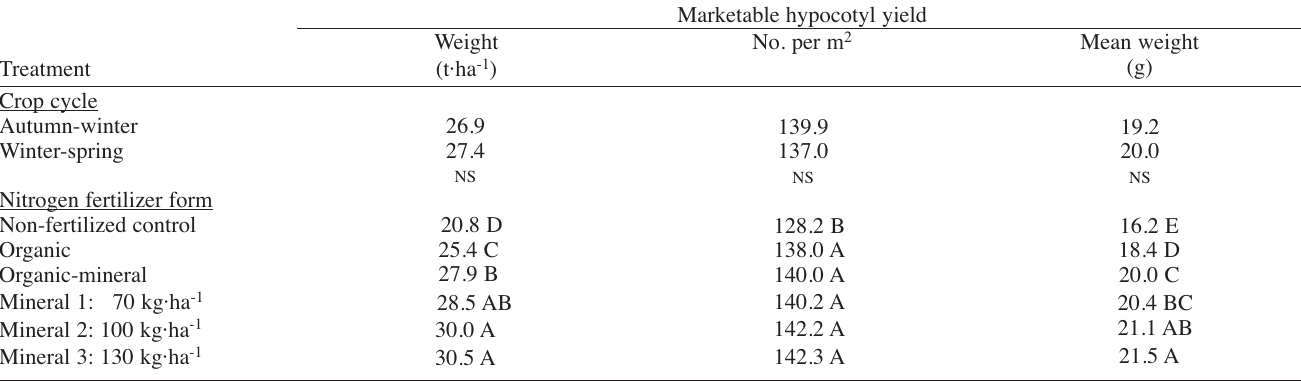
Table 4 - Radish under tunnel: hypocotyl yield as a function of crop cycle and nitrogen fertilizer form. Fondi (Latina, Italy), 2003-2004